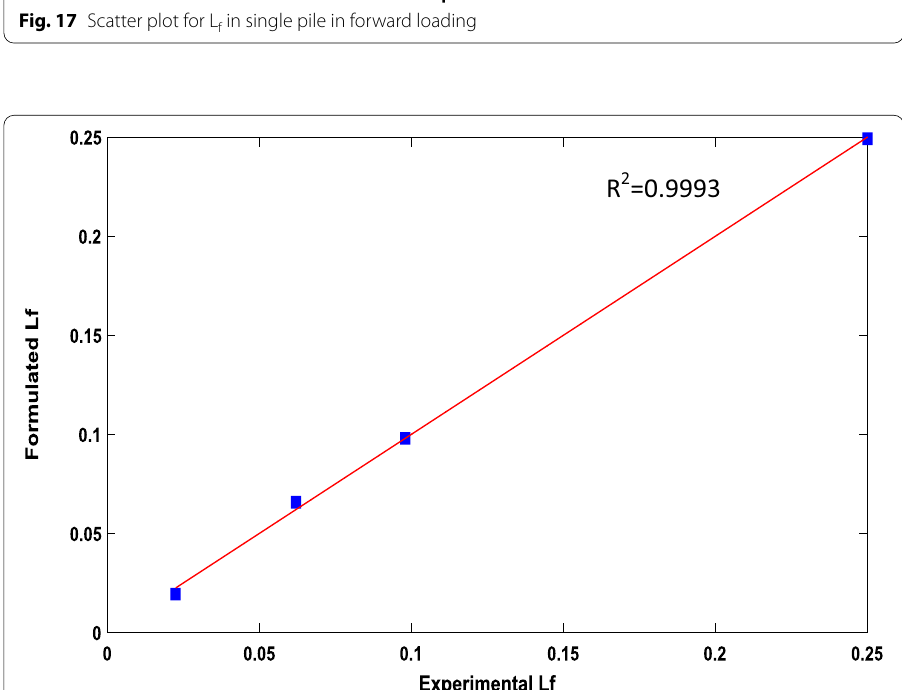
Fig. 18 Scatter plot for L f in single pile in reverse